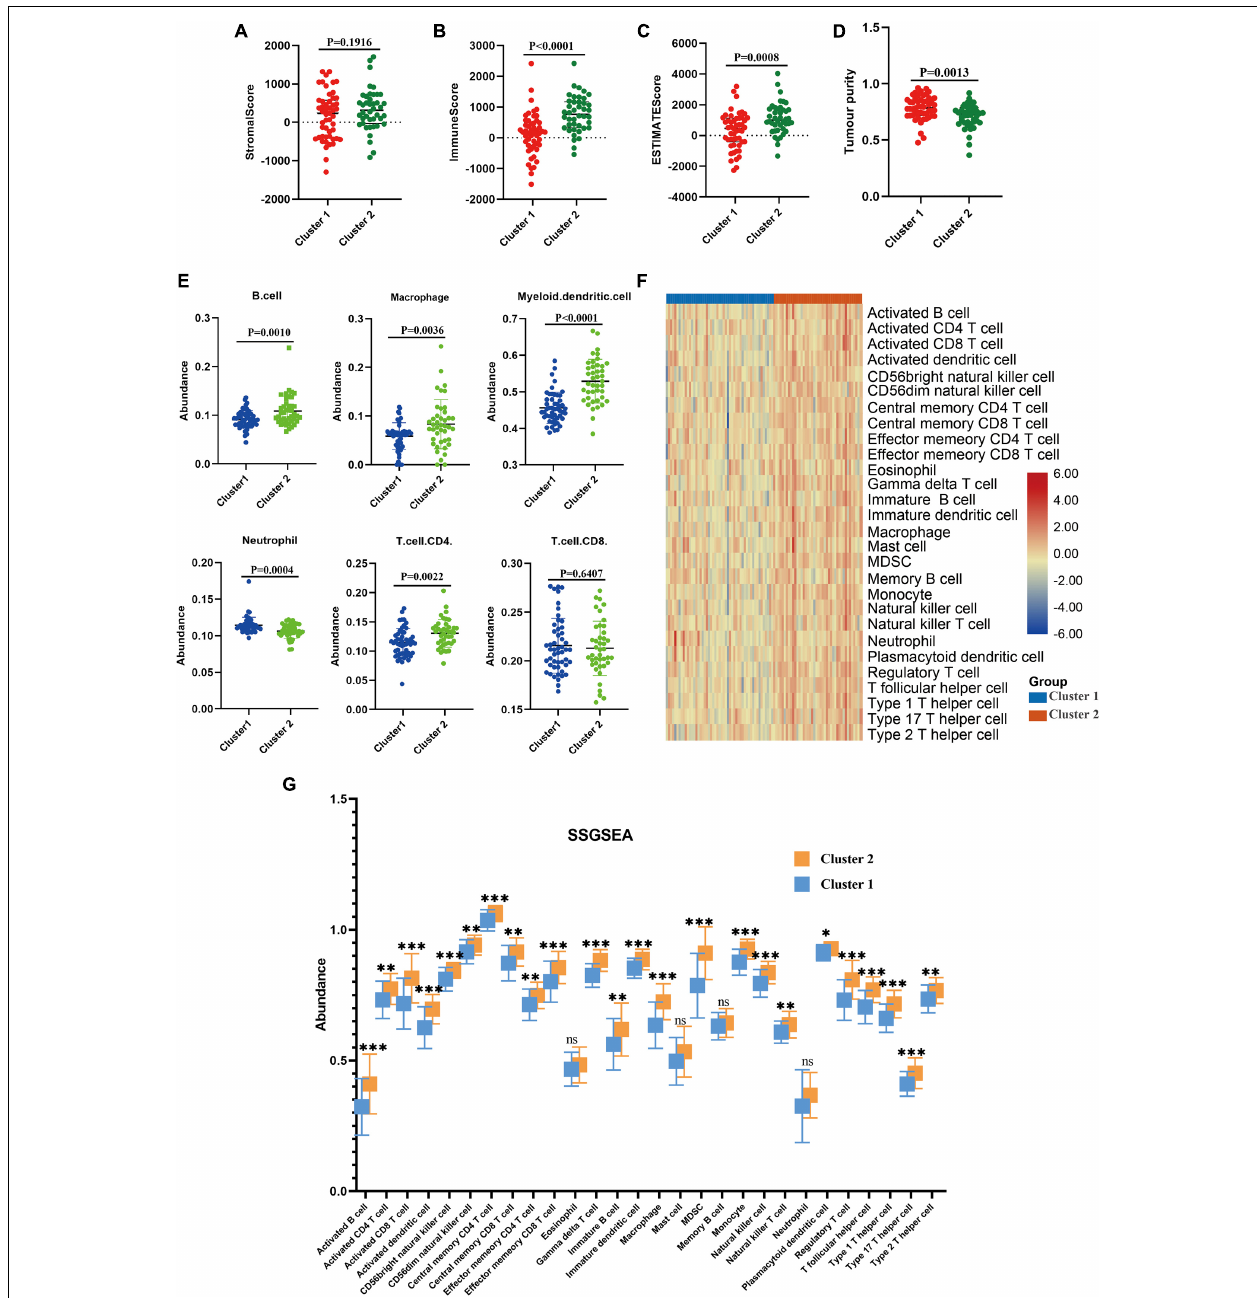
FIGURE 3 | Immune analyses in the two clustered subgroups. (A) stromal score, (B) immune score, (C) ESTIMATE score and (D) tumor purity calculated by ESTIMATE algorithm, (E) abundance of six immune filtrating cells evaluated by TIMER, (F) heatmap depicting the enriching level of 29 immune related cells evaluated by ssGSEA algorithm, (G) statistical analysis of ssGSEA. * p < 0.05; ** p < 0.01; *** p <